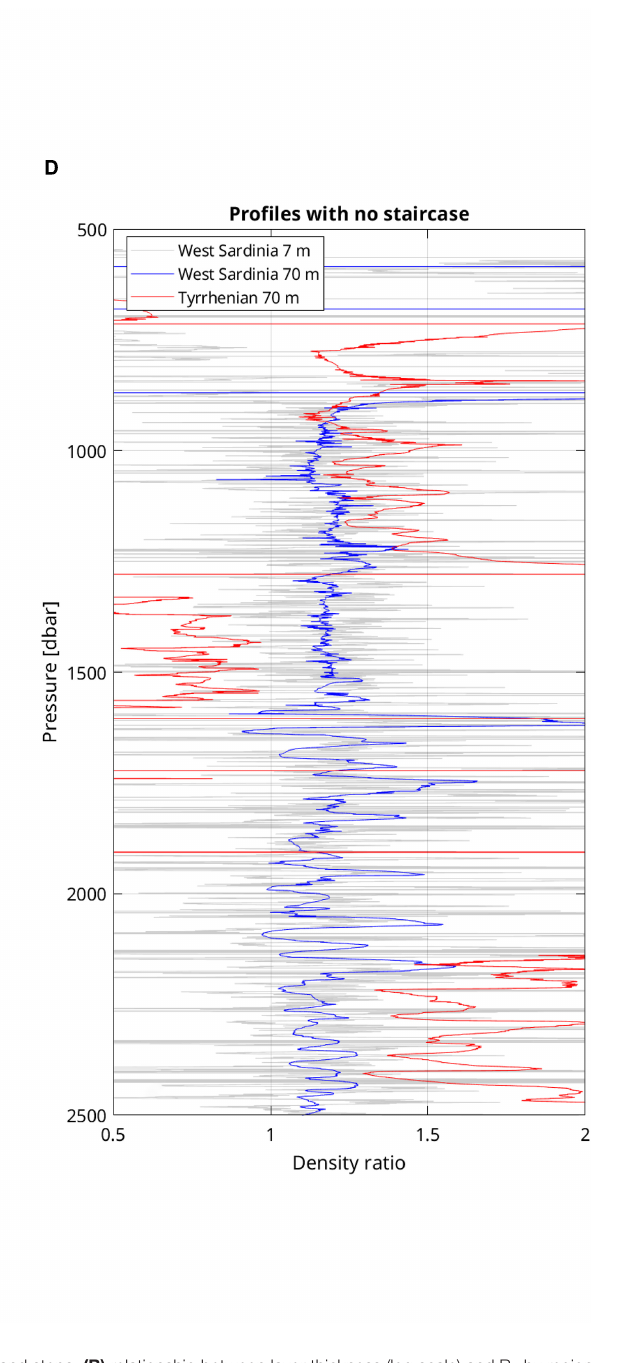
ICH. 14 #14) and may be the sign of lateral intrusions as observed by Taillandier et al.